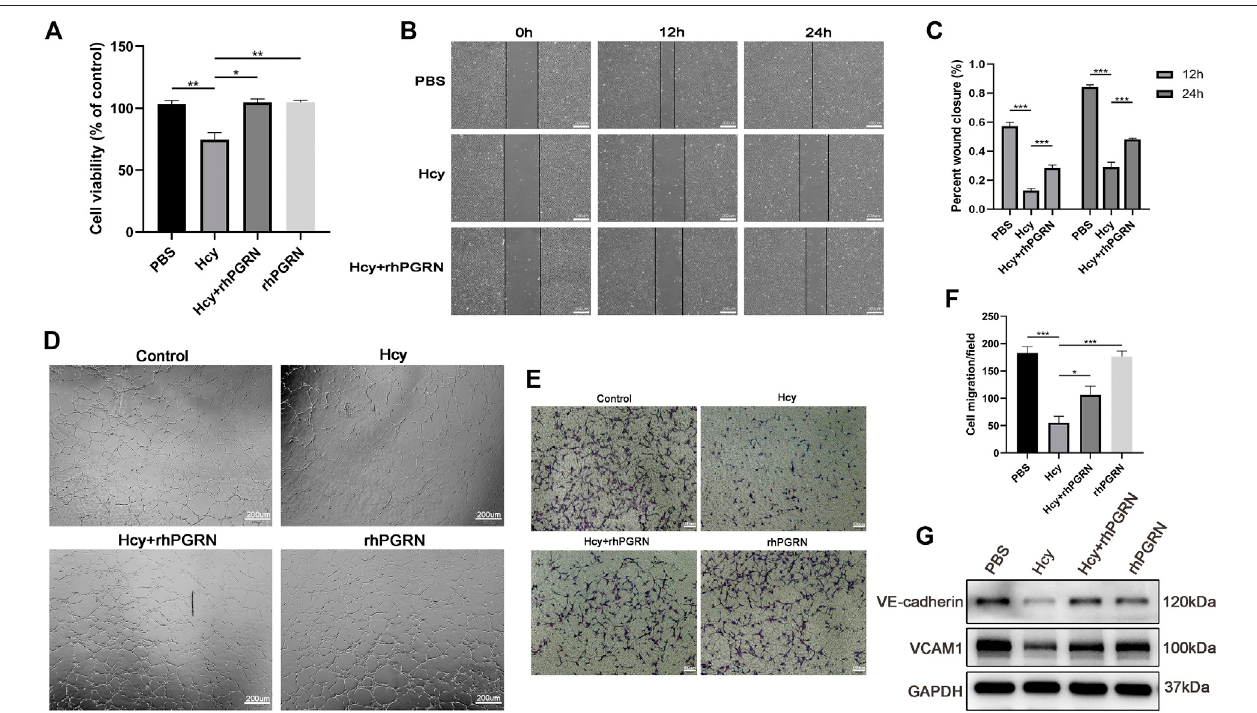
FIGURE5| RhPGRNamelioratedtheHcy-inducedreductionincellviabilityandmigration. (A) ResultsofcellviabilityinHUVECsafterstimulatedwith2.0 mMHcyin the presence or absence of 200 ng/mL rhPGRN (B,C) Results of the scratch wound assay were recorded and calculated at 12 and 24 h after stimulated with 2.0 mM Hcyinthepresenceorabsenceof200 ng/mL rhPGRN. Scalebar,200 μ m. (D) Thetube formationassayofHUVECs stimulated with2.0 mM Hcy,200 ng/mL rhPGRN, andHcy+rhPGRNfor6 h.Scalebar,200 μ m (E,F) ThecellmigrationwasevaluatedbytheTranswellcellmigrationassayinHUVECsstimulatedwith2.0 mMHcy, 200 ng/mL rhPGRN, and Hcy + rhPGRN for 6 ∼ 8 h. Scale bar, 100 μ m. (G) Western blotting analysis of the protein levels of VCAM1 and VE-cadherin stimulated with 2.0 mM Hcy in the presence or absence of 200 ng/mL rhPGRN for 24 h. Data are presented as means ± SEM (* p < 0.05, ** p < 0.01, *** p < 0.001 vs. vehicle control, ANOVA, n (cid:1) 3 or